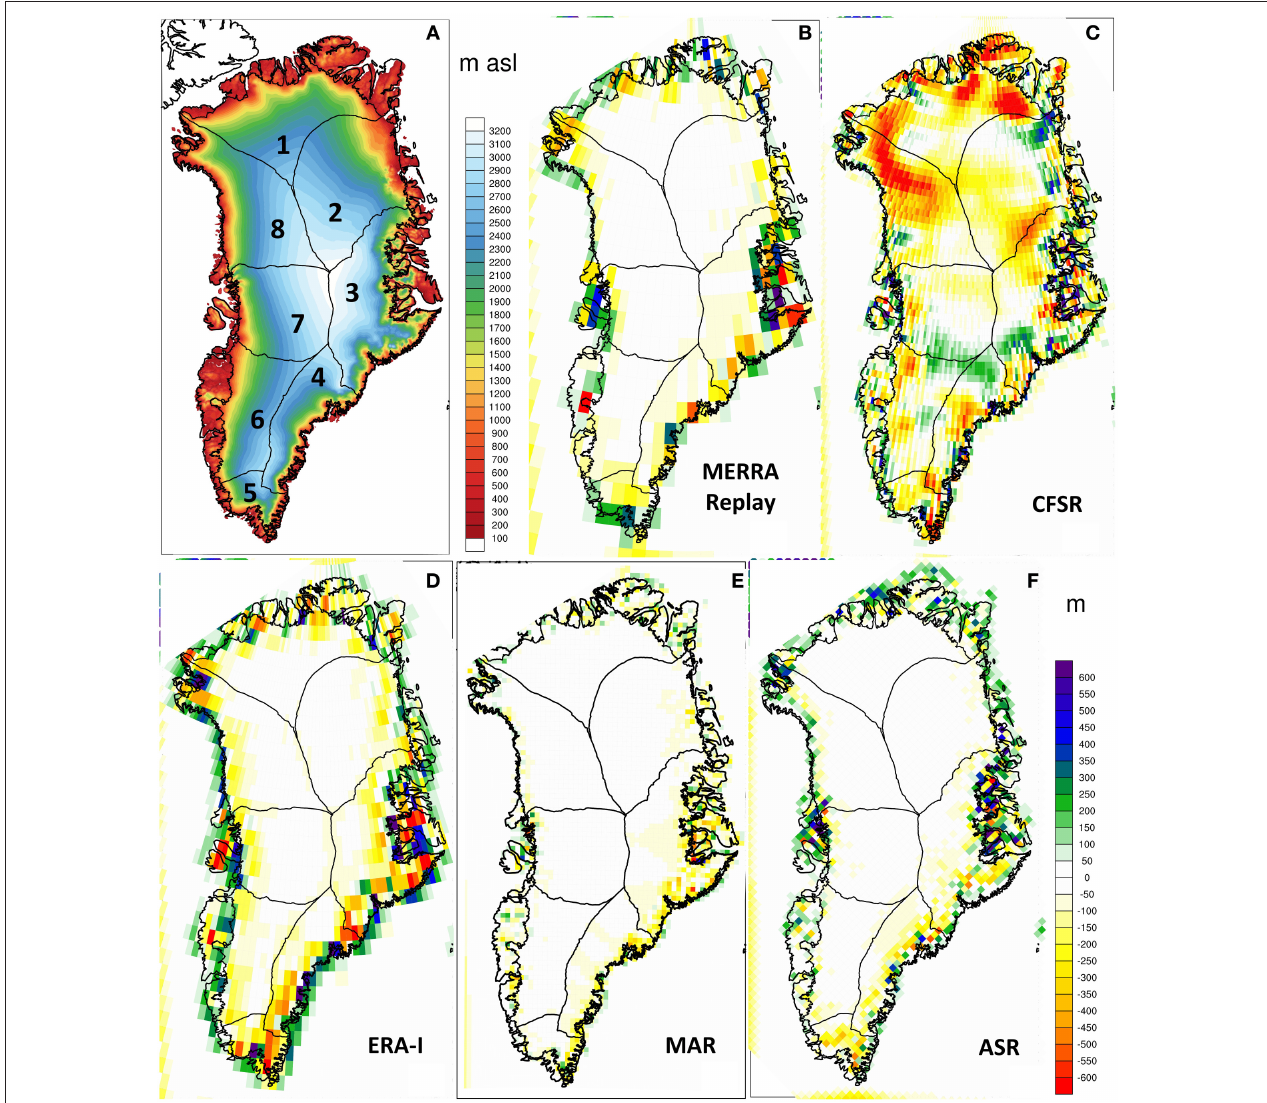
FIGURE 1 | (A) Greenland surface elevation from Bamber et al. (2001) contoured every 100m asl, and differenced with (B) MERRA-replay (C) CFSR, (D) ERA-I, (E) MAR, and (F) ASR, in m. The major GrIS drainage basins of Zwally et al. (2012) are numbered in (A) and indicated in each difference plot.